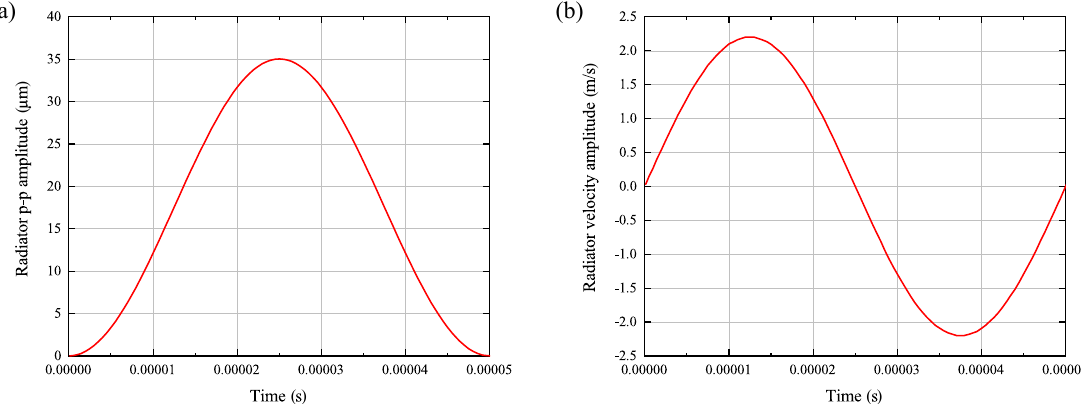
Figure 2. Analysis of calculated radiator movement: ( a ) actually calculated radiator amplitude and ( b ) velocity amplitude and